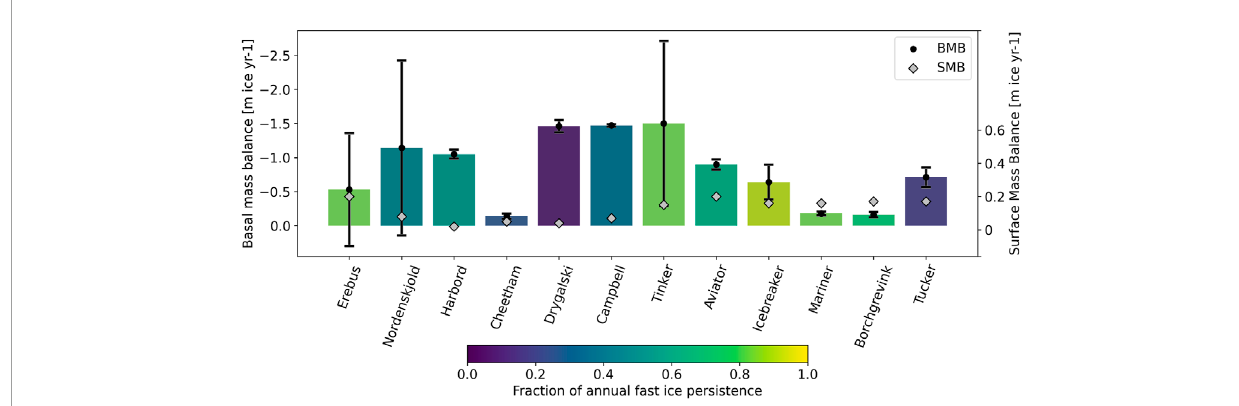
FIGURE 4 Basal melt rates (with confidence intervals) of ice tongues along the Victoria Land Coast. Ice tongues are ordered from South to North. The colour scale represents the land-fast sea ice permanence surrounding the ice tongue, colours as per Figure 1 . The average surface mass balance van Wessem et al. (2014) is shown as grey diamonds with an exaggerated